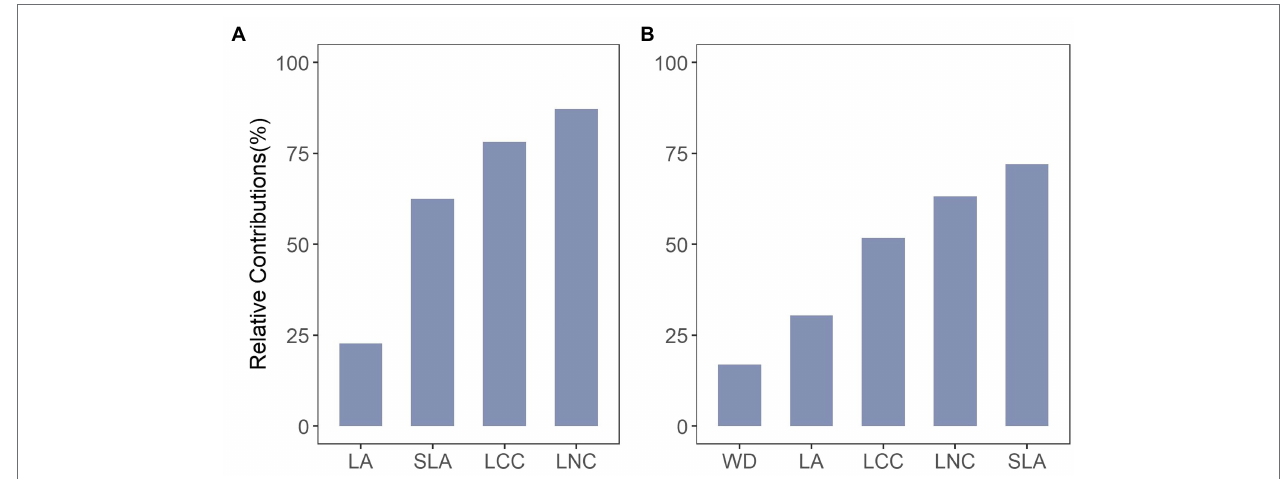
FIGURE 2 | Relative contributions of intraspecific trait variation to explaining variability in total trait variation for traits at (A) local scale and (B) regional scale. LA, leaf area; LCC, leaf carbon content; LNC, leaf nitrogen content; SLA, specific leaf area; WD, wood